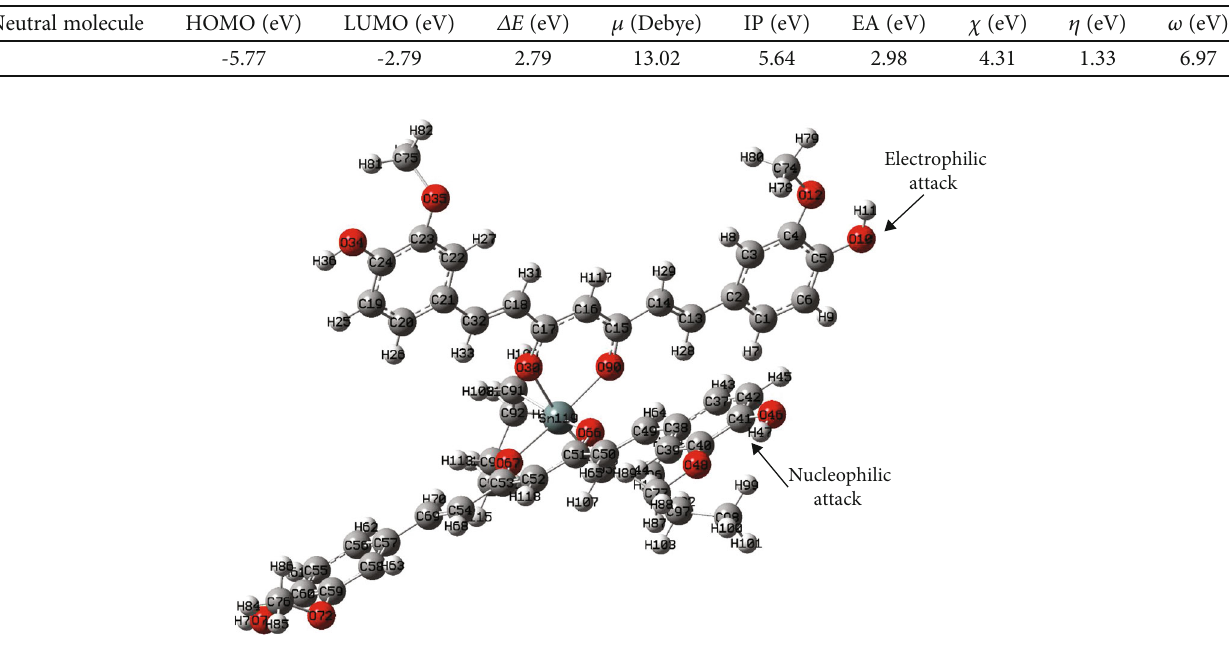
Figure 11: Fukui function distribution for electrophilic attack and nucleophilic attack for the Sn-metallic complex, SnX molecule. Table 6: The calculated quantum chemical descriptors for protonated SnX molecule obtained using DFT at the B3LYP/LANL2DZ basis set in aqueous phase.